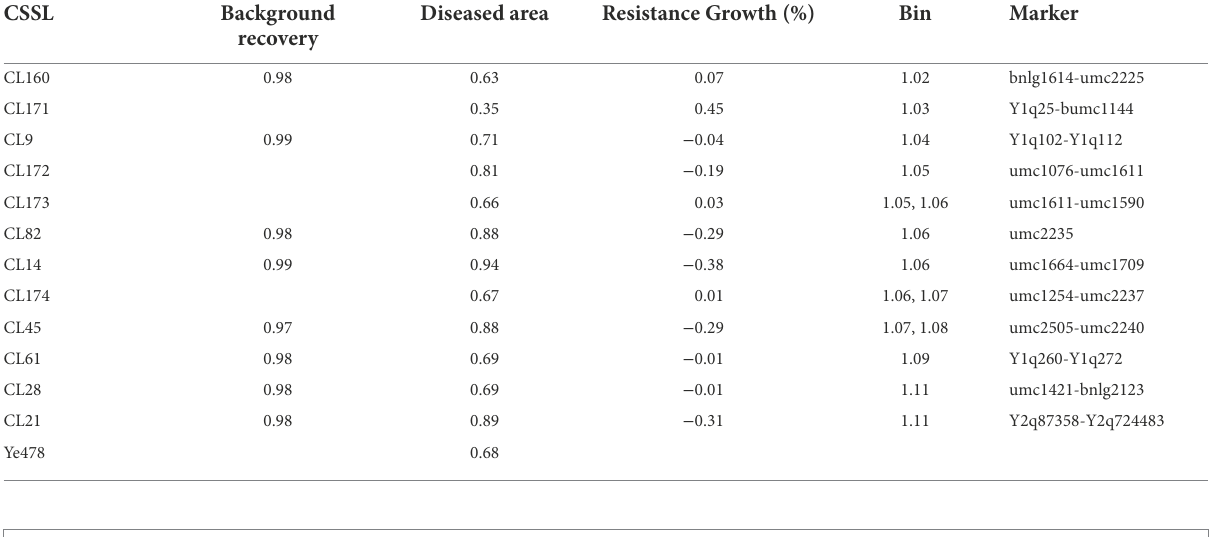
TABLE 4 Comparison of the FER resistance between the CSSLs and the susceptible control line Ye478.